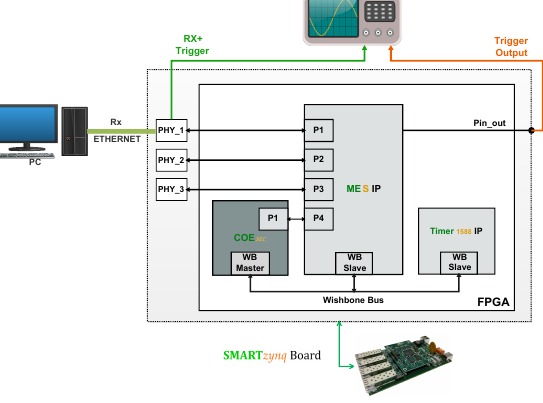
Figure 7. Concept-proof set-up for module COEsec. The oscilloscope is used to measure the time required to process a COEsec frame since it enters the Ethernet interface until the internal register is modified.